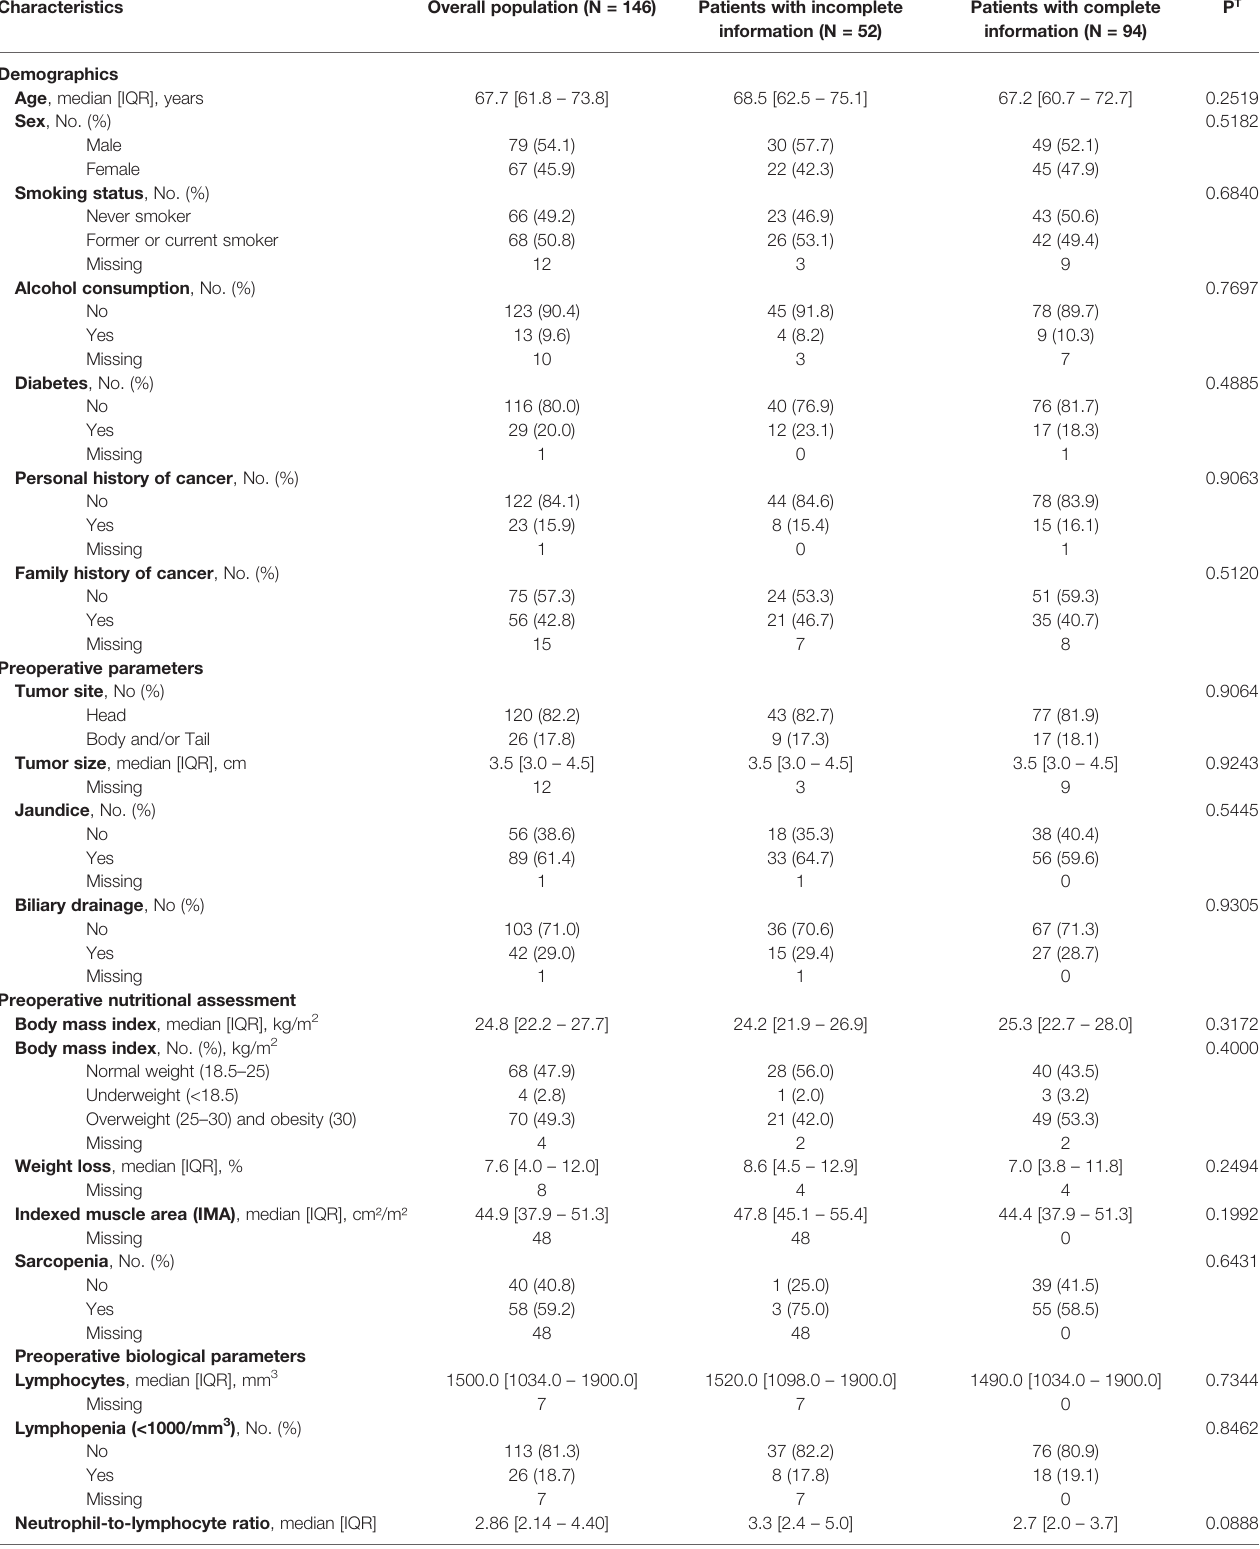
TABLE 1 | Patient characteristics with surgical resection of